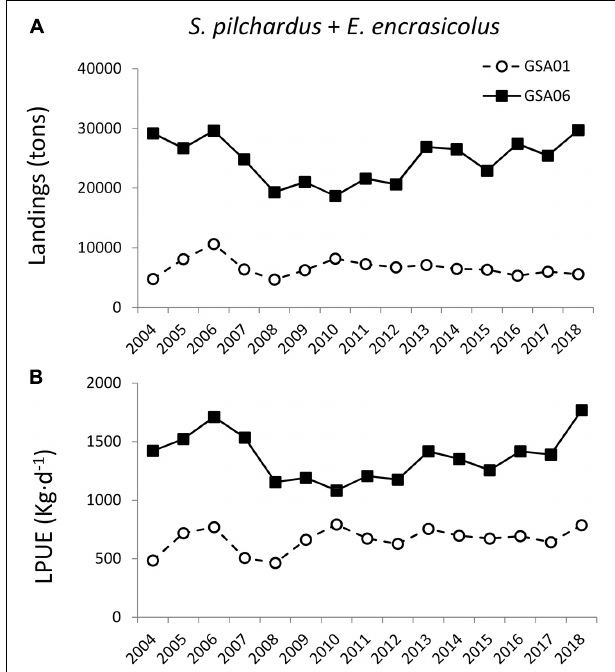
FIGURE 7 | Interannual variability (2004–2018) of combined European sardine ( Sardina pilchardus ) and European anchovy ( Engraulis encrasicolus ) (A) landings (tons) and (B) LPUE (kg · d − 1 ) in GSA01 and